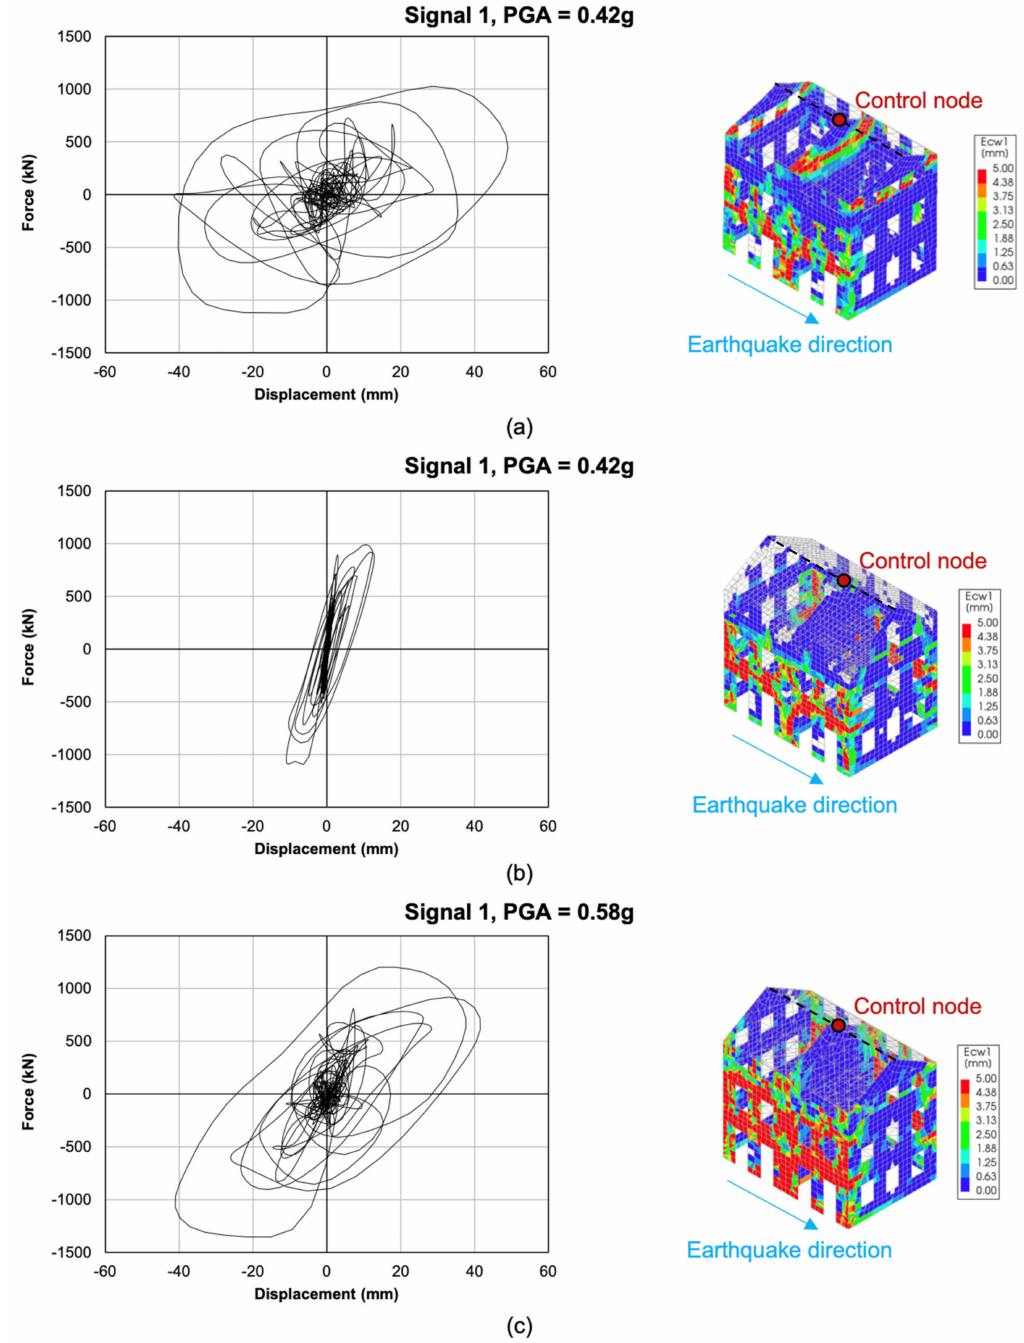
Figure 14. Base shear vs. top roof displacement response and damage level in terms of the principal crack opening (Ecw1) for the three configurations: B3-AB ( a ), B3-RC ( b ), and B3-PP ( c ) at a near-collapse